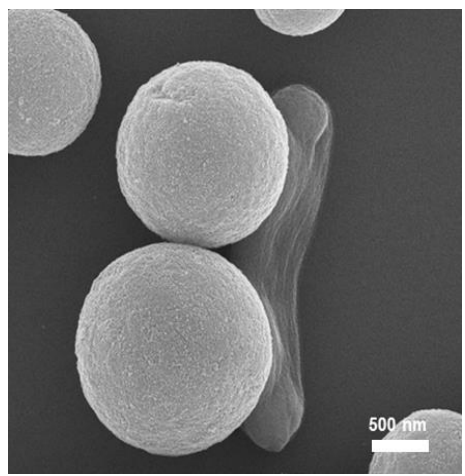
Figure 5. Representative SEM image of target E. coli O157:H7 captured by immunomagnetic beads